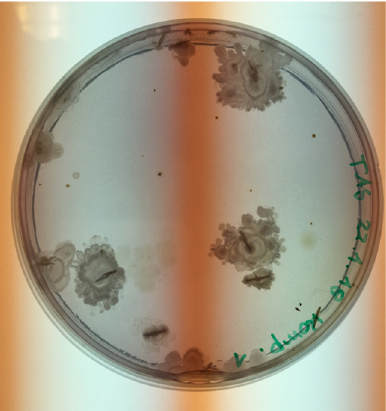
Figure 1. Grown thermophilic aerobic sporeformers (TAS) colonies on a Dextrose Tryptone Agar plate after incubation at 55 °C for 48 h.